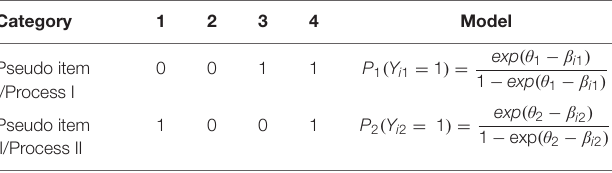
TABLE 8 | Decomposition of the mathematics self-efficacy items into pseudo items. Category 4